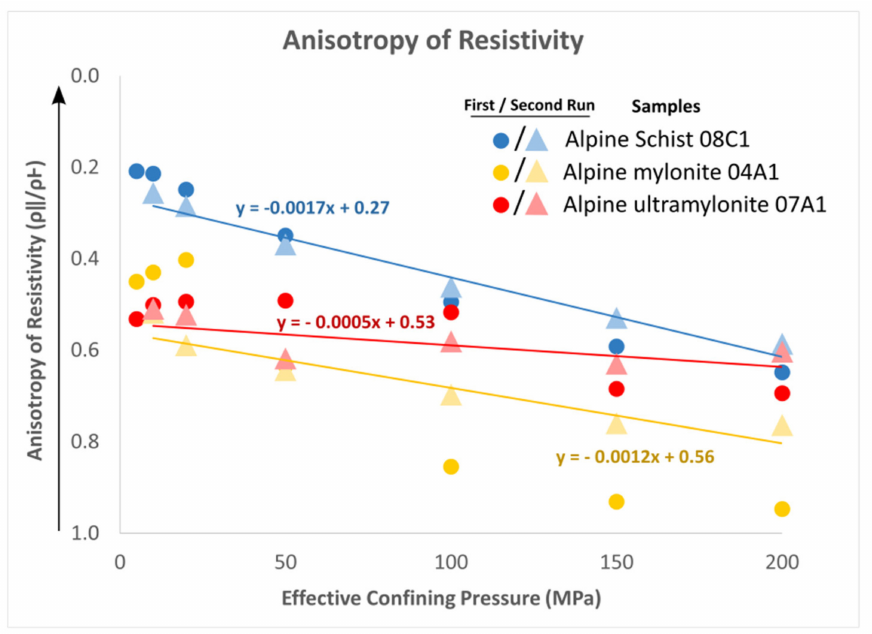
Figure 7. Anisotropy of resistivity of Alpine Fault rocks over ranges of effective confining pressure, derived from both First and Second Run data. Anisotropy of resistivity here was defined as the ratio of the resistivity parallel to foliation ( ρ (cid:107) ) to the resistivity perpendicular to foliation ( ρ (cid:96) ), as shown in Equation (6). Therefore, anisotropy is greater at 0 than 1, indicated by the arrow on the vertical axis. The trendline and the corresponding equation, based on Second Run data, is depicted for each sample. The Second Run data were used to generate the trendlines, since they display more systematic linear relations to confining pressure, which we infer relates to closure of exhumation cracks during the First